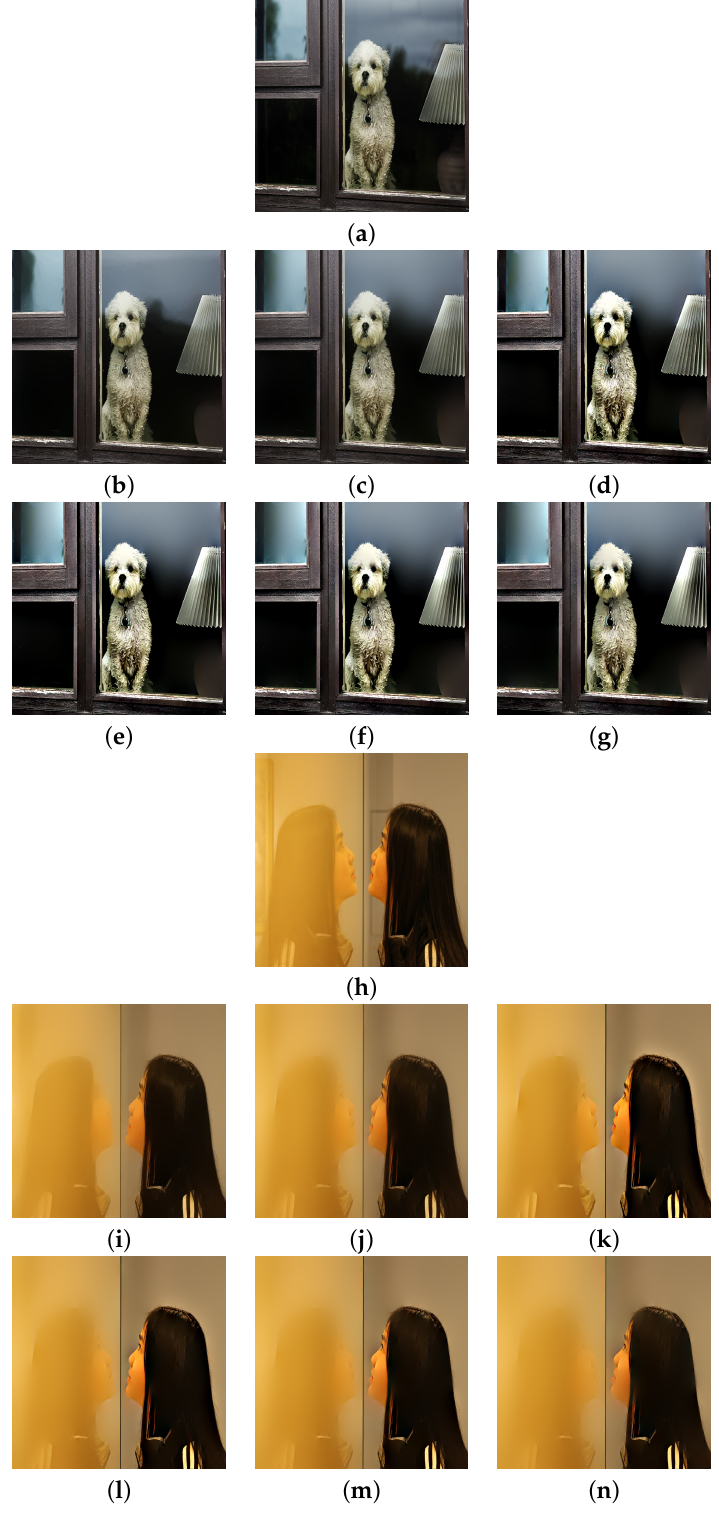
Figure 6. Reflection suppression results for real glass images ‘Dog’ and ‘Girl’. ( a , h ) Input images. ( b , i ) The results of algorithm [2]. ( c , j ) The results of algorithm [3]. ( d , k ), ( e , l ), ( f , m ), and ( g , n ) are results of the proposed algorithm with N = 1,2,3,4,